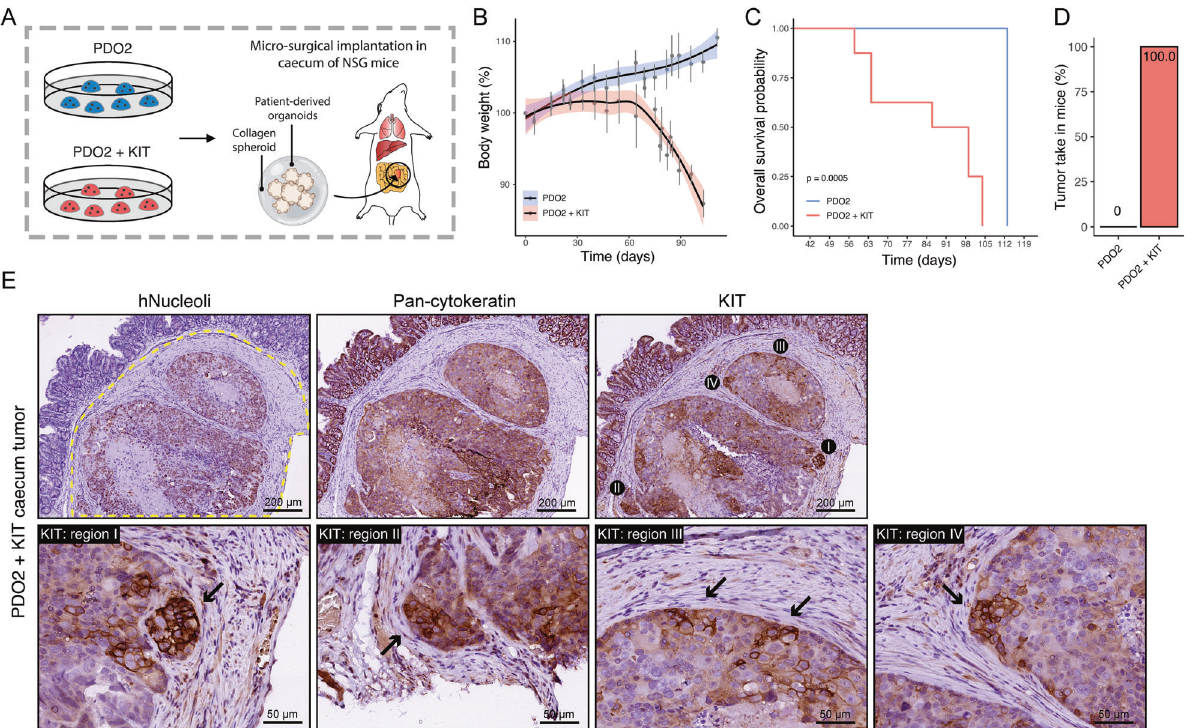
Fig. 7 KIT expression promotes the formation of stroma-rich tumors in the mouse caecum. A Schematic overview of orthotopic implantation of PDO2 CONTROL and PDO2 KIT in the submucosa of NSG caecum. B Body weight during the experiment, day 0 is start of the experiment. C Kaplan – Meier curve demonstrating overall survival in PDO2 CONTROL and PDO2 KIT implanted mice. D Tumor take in mice, i.e., successful engraftment of implantation and formed primary tumors. E Histological images of human Nucleoli, pan-Cytokeratin, and KIT in primary tumors derived from mice, which were implanted with PDO2 KIT . Scale bars are 200 and 50